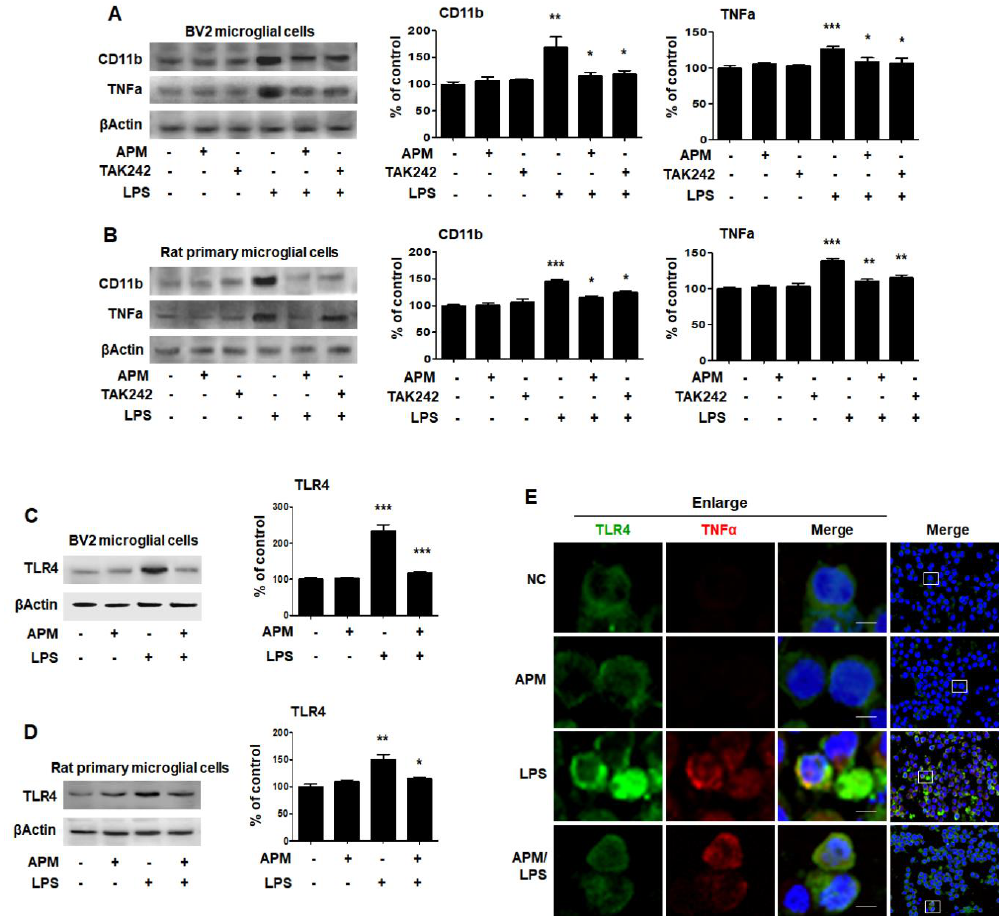
Figure 3. APM inhibits LPS-induced CD11b and TNF α expression by inhibiting TLR4 in BV and rat primary microglial cells. Cells were treated with APM for 1 h followed by LPS for 12 h. CD11b and TNFα expression were significantly inhibited in LPS-stimulated BV2 ( A ) and rat primary microglial cells ( B ) by TLR4 inhibitor, TAK242. Cells were treated with APM for 1 h followed by LPS for 6 h. APM significantly reduced LPS-induced TLR4 expression in BV2 ( C ) and rat primary microglial cells ( D ). Immunofluorescence double staining for TLR4 (green) and TNFα (red) localization ( E ) in BV2 microglial cells. Cell were counterstained with DAPI (blue). Magnification 400×. Enlarge figure of scale bars: 5 μm. βActin was used to confirm equal sample loading. CD11b, TNFα and TLR4 followed by densitometric analysis. The data are representative of three independent experiments and quantified as mean values ± SEM. Tukey’s multiple comparison test, * p < 0.05, ** p < 0.01, *** p < 0.001 compared to normal